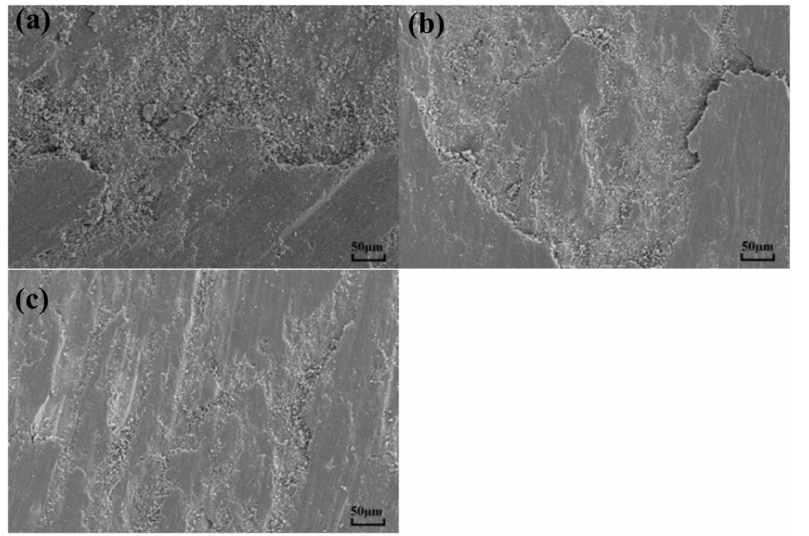
Figure 7. Worn morphology of MAO layer on TC4 alloy with different particle additions: ( a ) MAO,